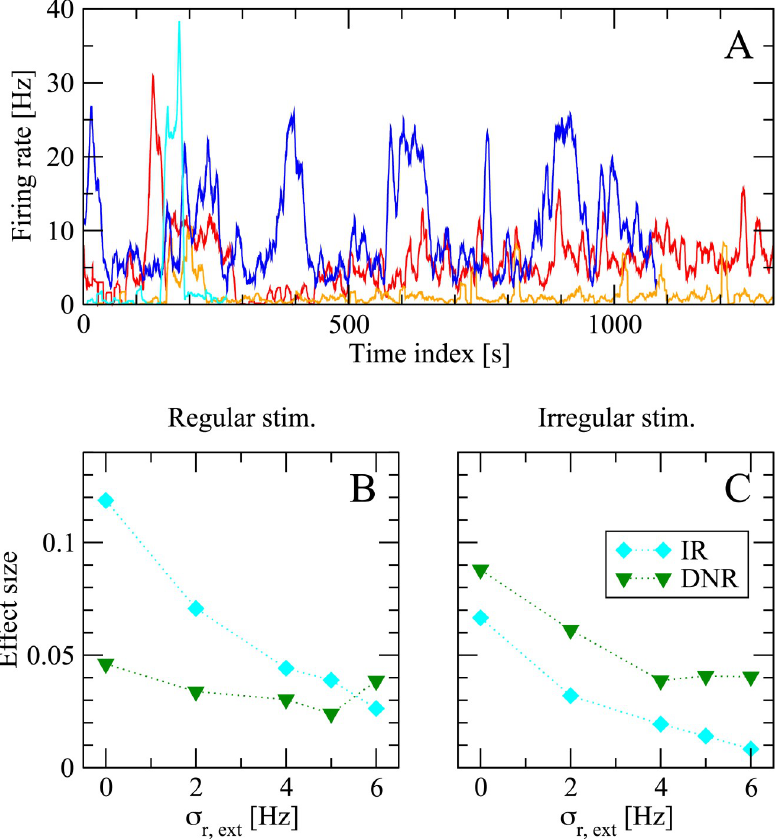
Fig 12. The differentiator network readout (DNR) is more robust than the integrator readout (IR) against static readout noise, a proxy for slow modulations of the background network activity. A : Firing rate of four different cells (filtered with a 1 sliding window) during juxtacellular recording sessions in the barrel cortex. The slow changes in firing rate are unrelated to stimulation events and give an example of slow non-stationarities present in vivo (note that the time window shown here is larger by orders of magnitude from the typical duration of a single trial in the detection experiments). B : Effect size measured in the model for the case of 400 ms stimulation on increasing σ r,ext , the standard deviation of the global background input (input readout noise). Light blue diamonds represent results obtained from the integrator readout (IR), whereas green diamonds are results from the differentiator network readout (DNR). C : same as B , but for the case that irregular stimuli are